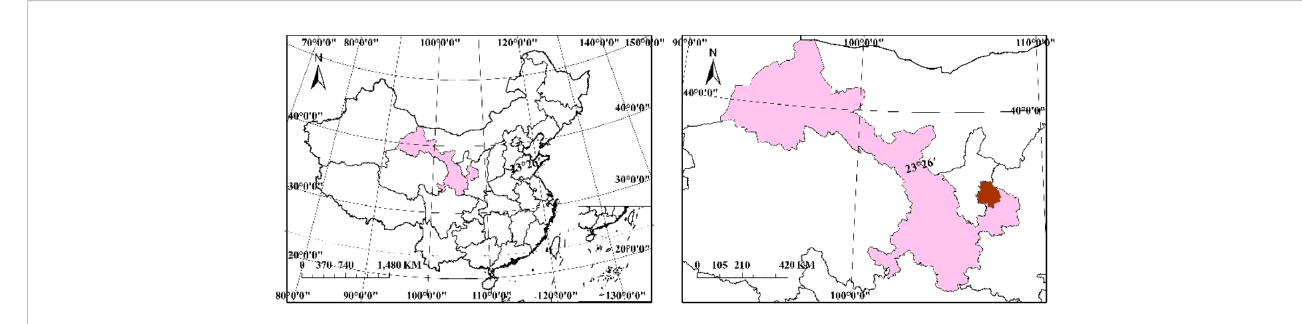
FIGURE 1 The geographical location of Huanxian test station.